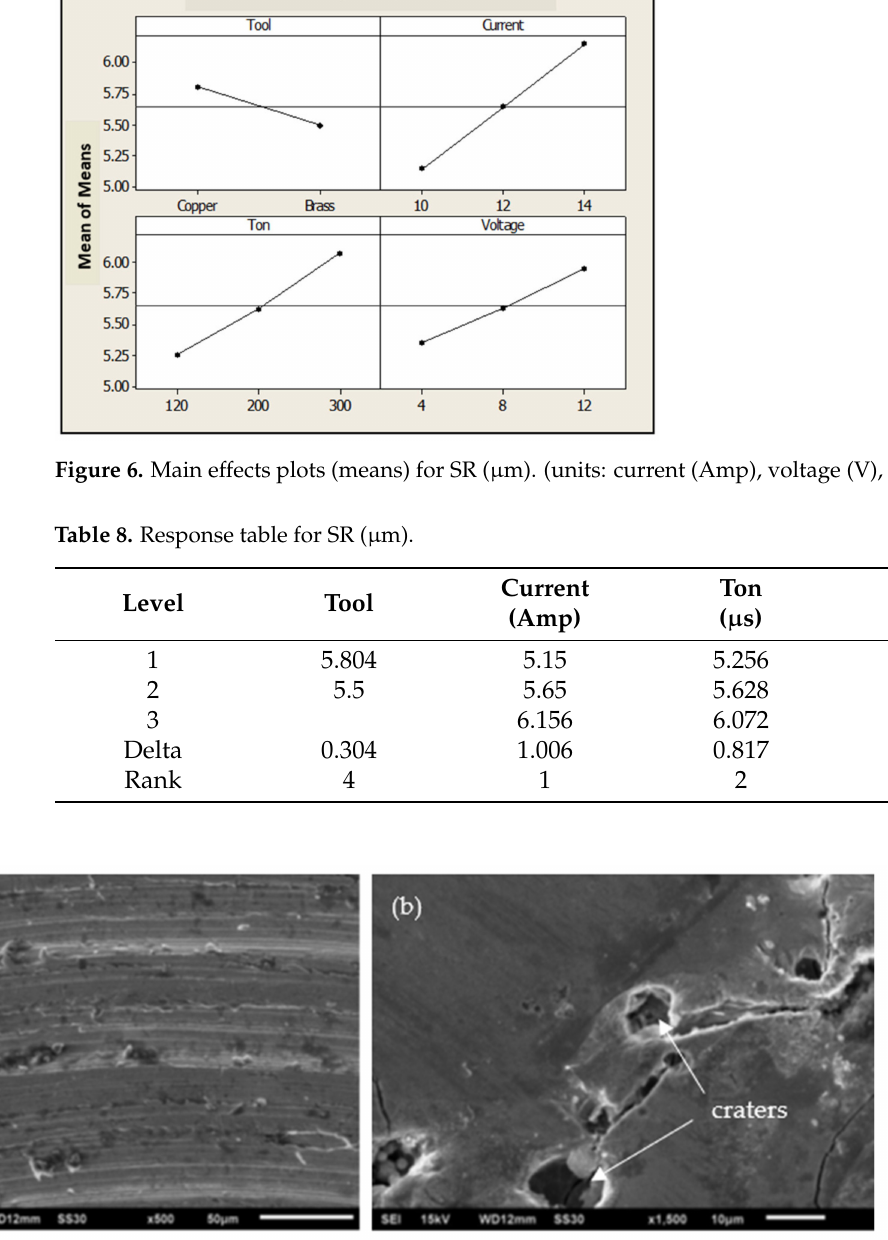
Figure 7. SEM images of machined workpieces: ( a ) R a = 4.7 ( µ m) at I = 10 (Amp), V= 4 (V), Ton = 200 ( µ s) and brass electrode; ( b ) R a = 5.4 ( µ m) at I = 10 (Amp), V= 4 (V), Ton = 200 ( µ s) and copper